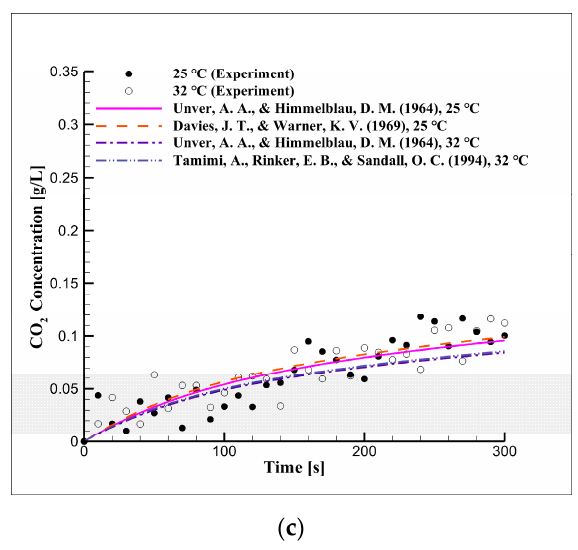
Figure 3. Short-term CO 2 concentration over time due to the equilibrium pressure and temperature in distilled water at pressures of ( a ) 2, ( b ) 3, and ( c ) 5 bar.